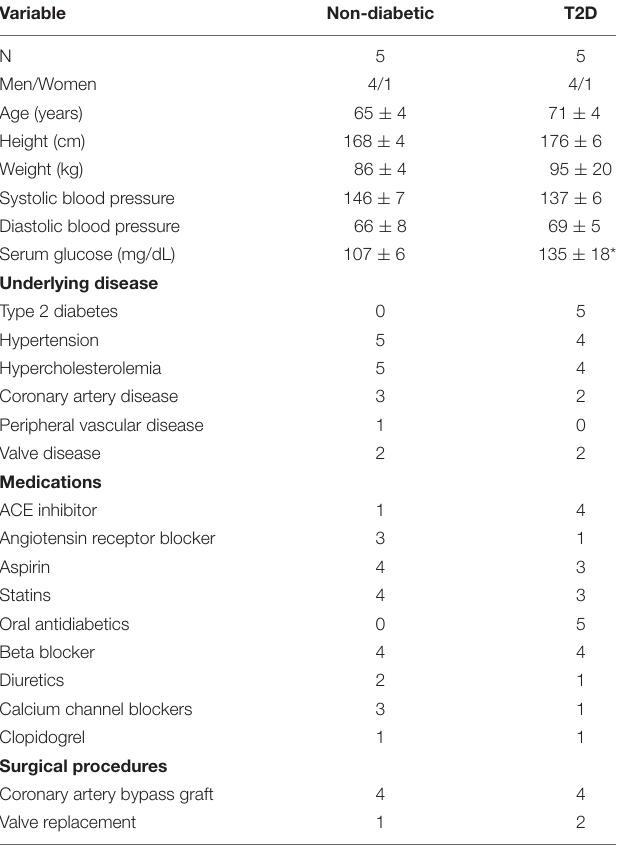
TABLE 1 | Patient demographics, diseases, medications, and procedures. Variable